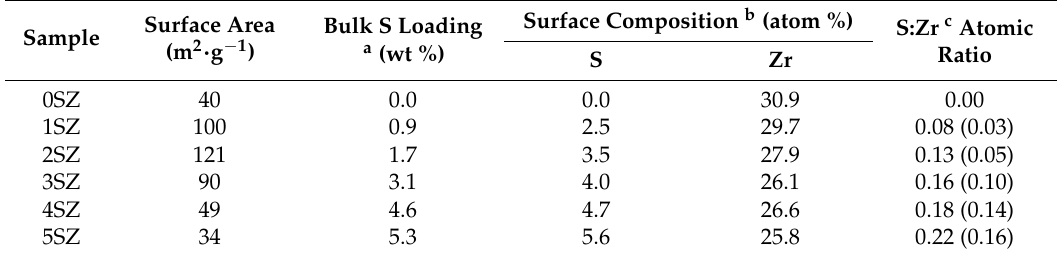
Table 1. Physicochemical properties of parent and sulfated